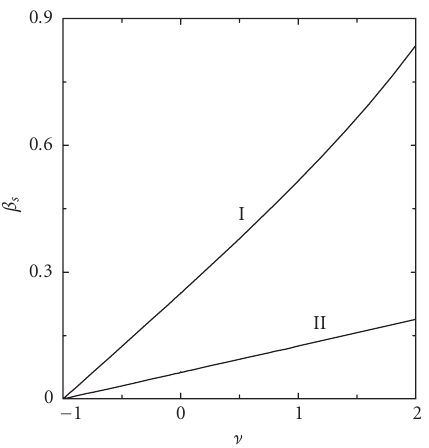
Figure 3.1. The variation of the smaller root β s of (3.10) as a function of the nonintegrability param- eter ν . Since λ = 1, these states are unstaggered stationary localized states. Curve I: α = 0 . 5 and curve II: α = 0 .